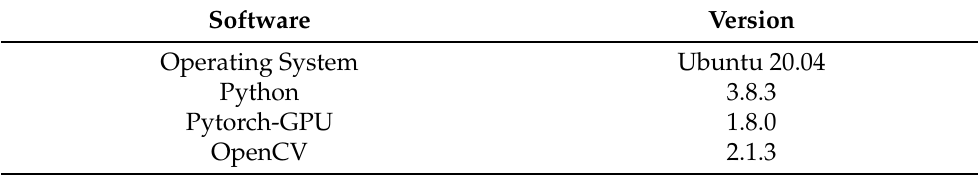
Table 5. Software